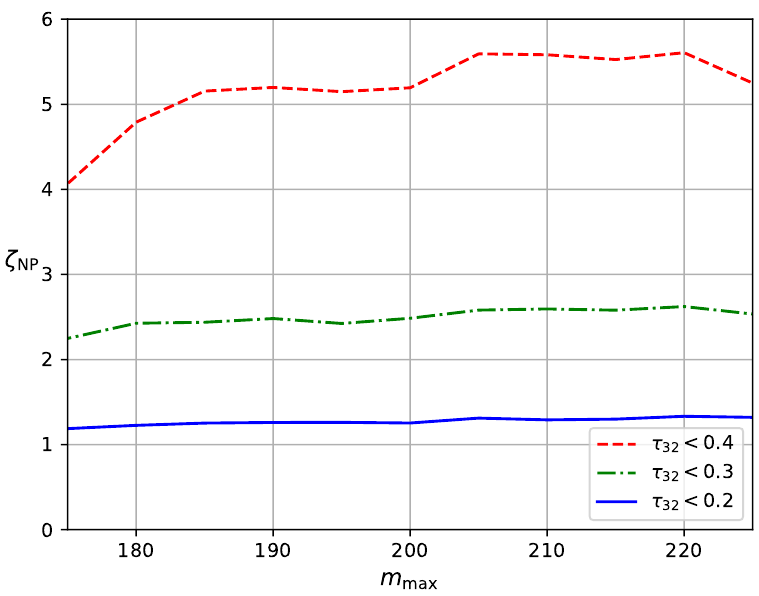
Figure 12. A measure of resilience to non perturbative effects as m max varies for three cuts on τ 32 . Jets are pre-groomed with